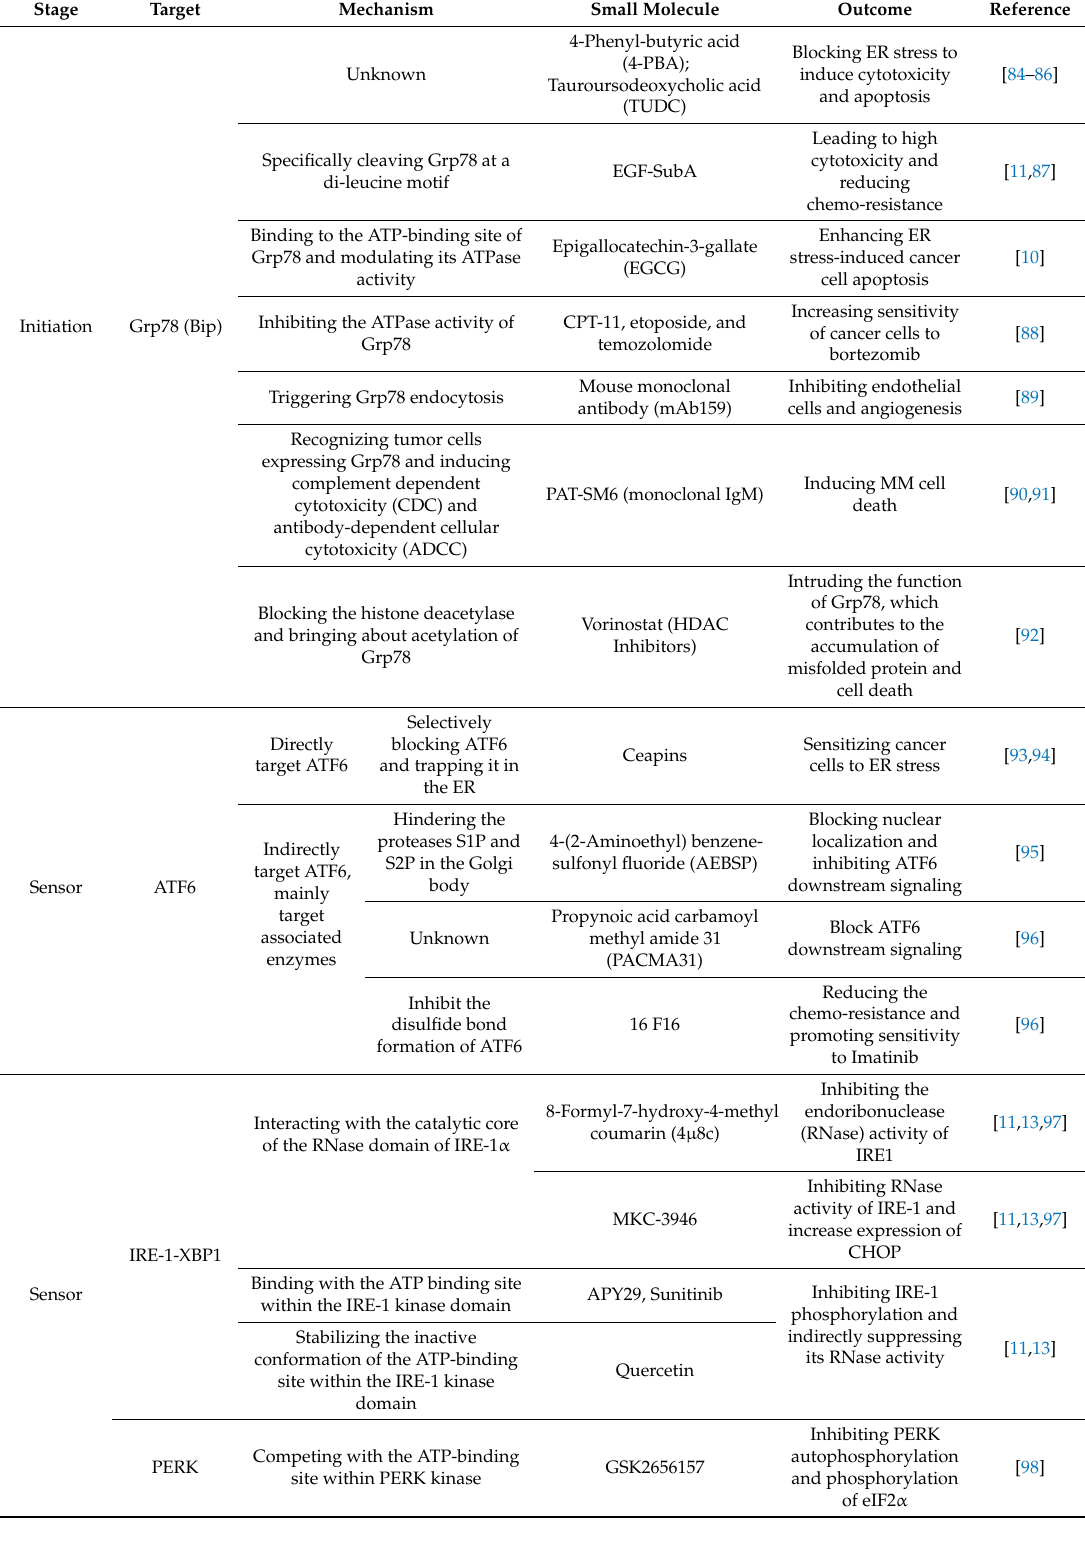
Table 1. Anti-cancer drugs targeting UPR